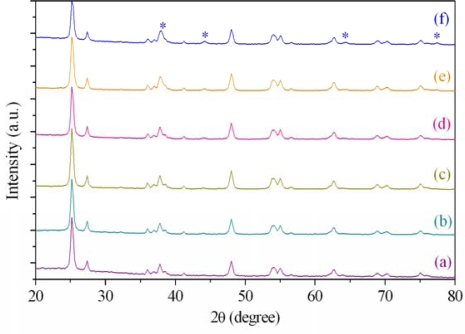
XRD patterns of (a) 0.0, (b) 0.5, (c) 1.0, (d) 2.0, (e) 5.0, and (f) 10.0 wt% Ag in TiO2. Ag signals were indicated by the asterisks.